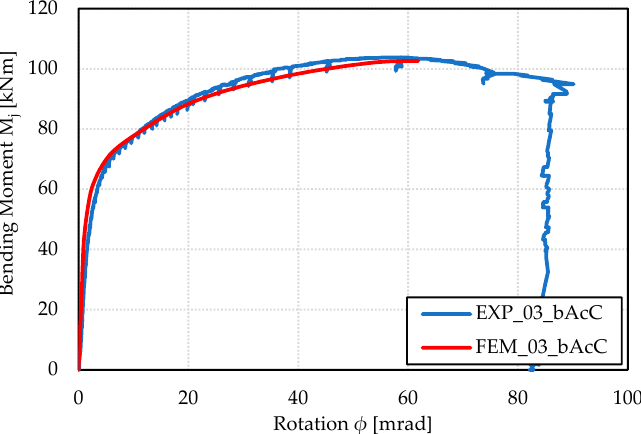
Figure 7. Experimental and FEM moment–rotation curve for steel beam-to-column joint.